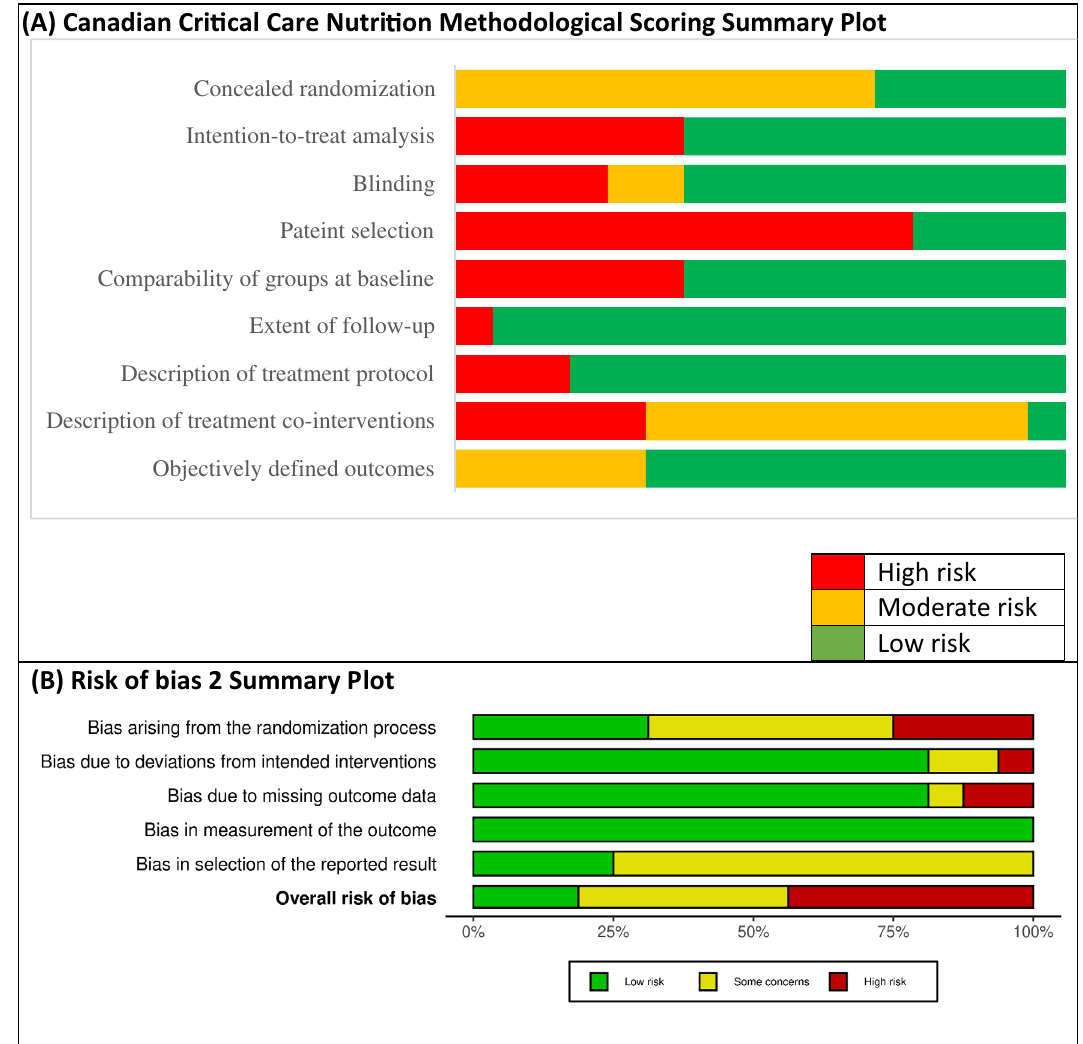
Fig. 1 Summary of A Canadian critical care nutrition methodological scoring and B risk of bias